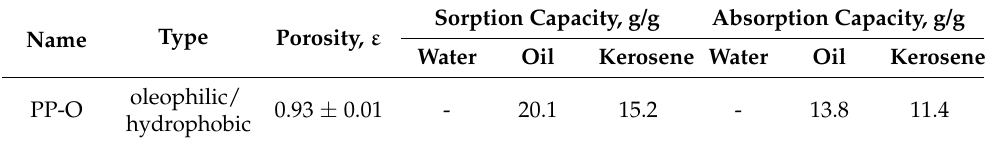
Table 2. Parameters of the fibrous